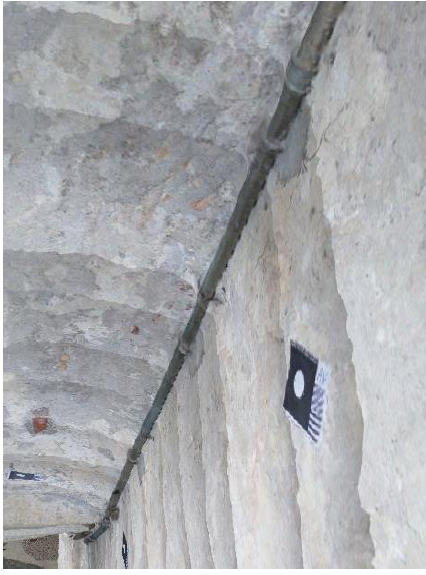
Figure 18: 3D reconstruction result for the section of the top pipe. An appropriate result is observed.